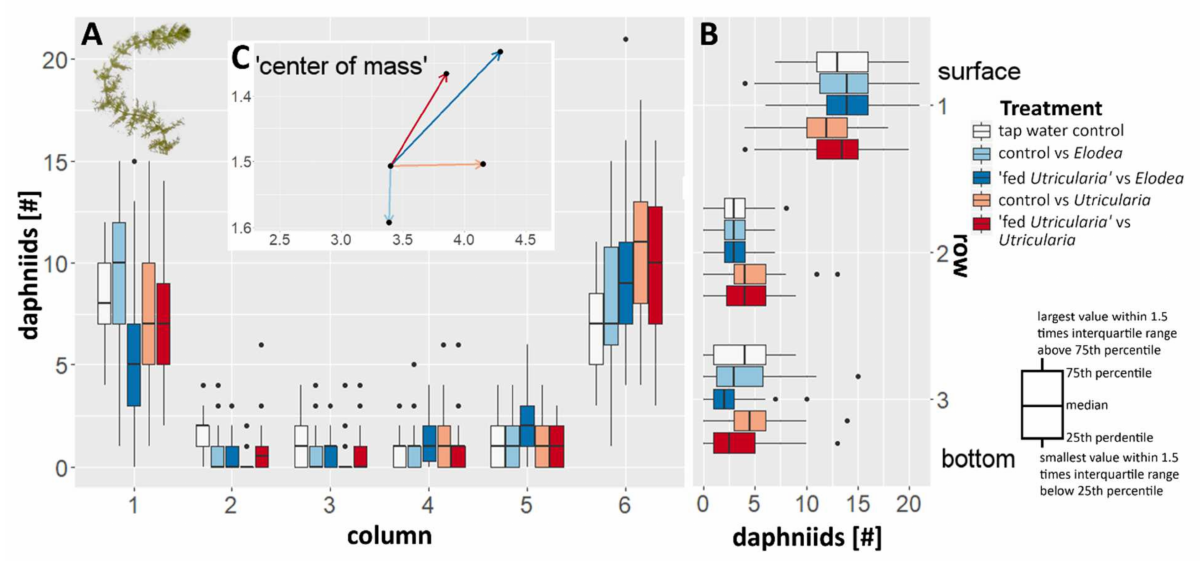
Figure 4. Changes in behavior in C. dubia observed as averaged distribution pattern with respect to the presence of either U. x neglecta or E. canadensis . ( A ) The box plots indicate the number of animals per column in the canvas drawn on the tank front pane. Increasing numbers on the x axis are equal to an increase in distance to the respective plant used in that treatment (1 equals to the same column as the plant, 6 is the opposite tank side). ( B ) The box plots indicate the number of animals per row. ( C ) The additional vector graph inlet is indicating the average positioning of the animals in respect to the plant by depicting a vector that represents the ‘calculated center of mass’ for every treatment as an offset from the tap water control treatment.